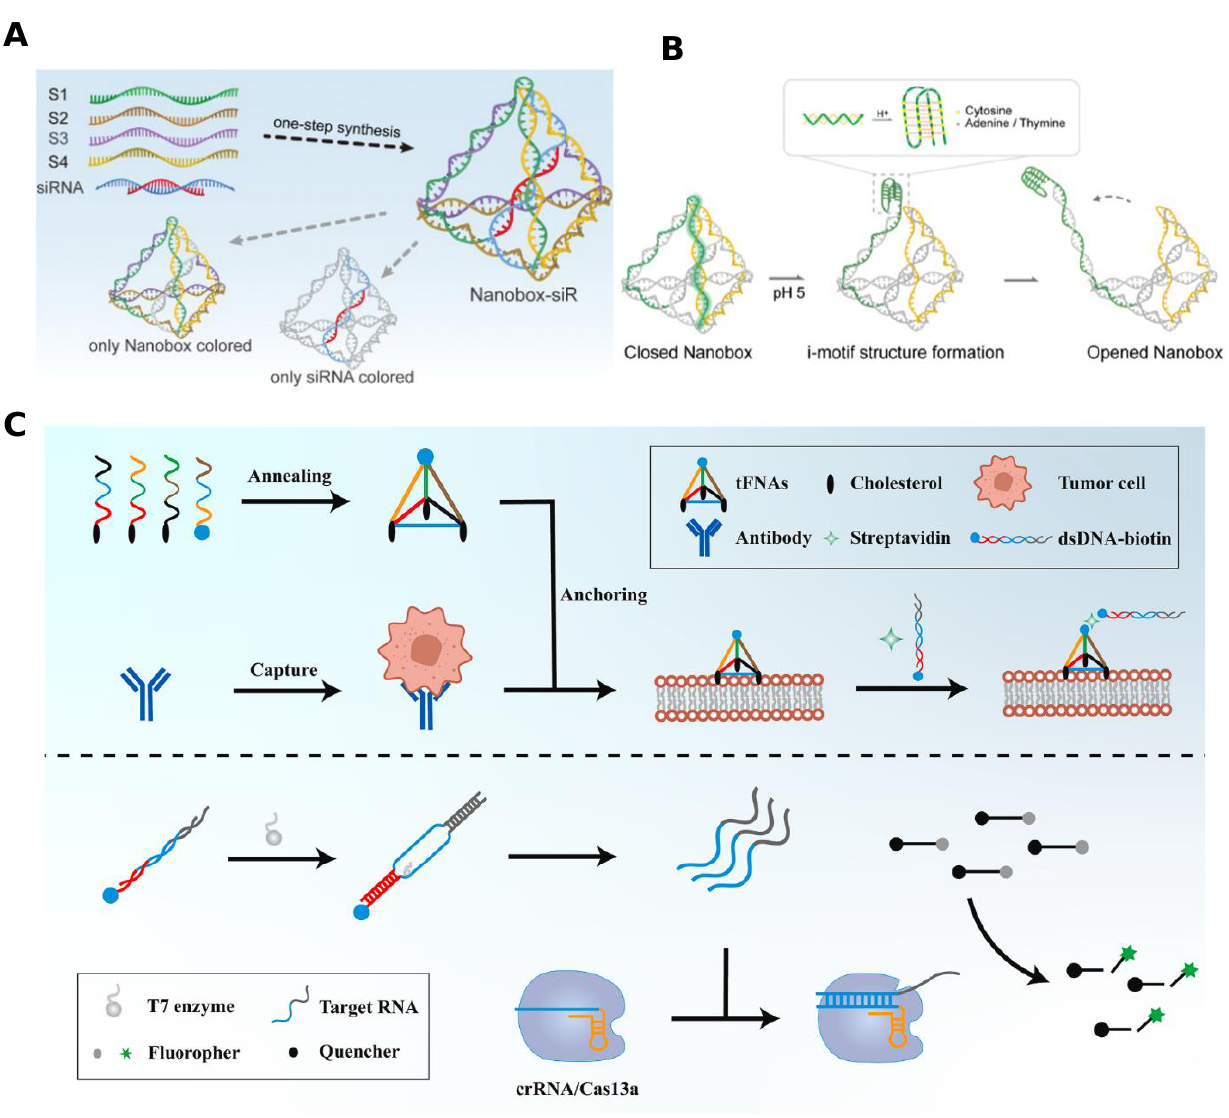
Figure 4. Schematic diagram of the nanobox-siR synthesis ( A ) and structural transition of its pH- responsive switch ( B ). The tetrahedral nanobox exoskeleton and siRNA encapsulation and protection were formed simultaneously by one-pot annealing (95 °C for 10 min and 4 °C for 20 min). At pH = 5, the nanobox nucleic acid sequence is transformed into a four-stranded I-motif structure, which subsequently leads to structural disintegration of the spatial tetrahedron and release of the target siRNA [96]. Copyright 2022, Wiley-VCH. ( C ) Schematic diagram of tFNAS-Cas13a synthesis process and its action on cancer cells. These cells were surface engineered using amphipathic tFNA with three cholesterol-modified vertices and one biotin-modified vertex. T7 polymerase recognizes dsDNA in the T7 promoter region and simultaneously generates a large number of copies of single- stranded RNA. Cas13a recognizes target RNA to activate CRISPR/Cas13a trans cleavage capability, and ssRNA with a fluorophore and quench groups is cleaved by this RNA cleavage capability [97]. Copyright 2022, Elsevier.